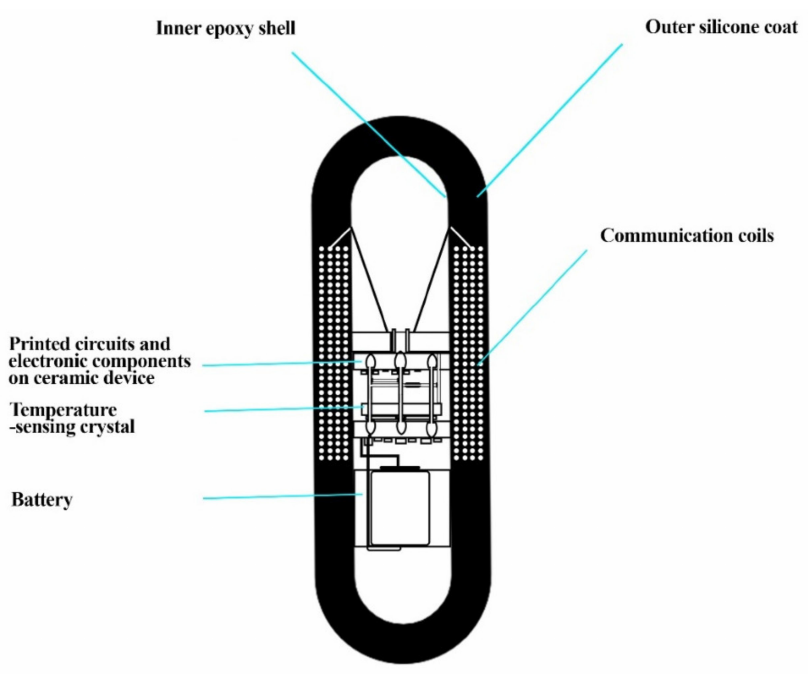
Figure 4. The ingestible thermal monitoring system showing inner epoxy shell, outer silicone coat, printed circuits, temperature-sensing crystal, and communication coils. This diagram was redrawn from